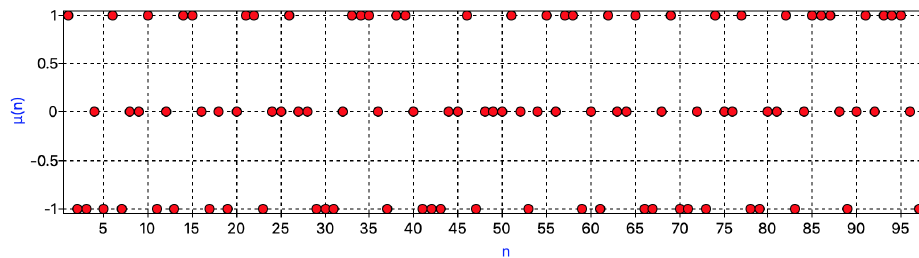
Figure 7. The simulation for µ ( n ) with 1 ≤ n ≤ 100.